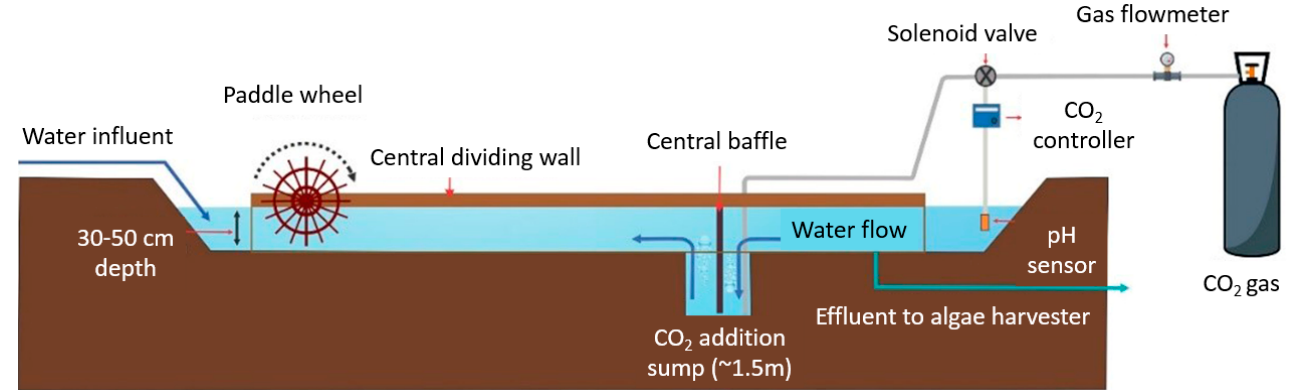
Figure 1. Side elevation of HRAP for wastewater treatment using microalgae with CO 2 addition to enhance algal growth [52].